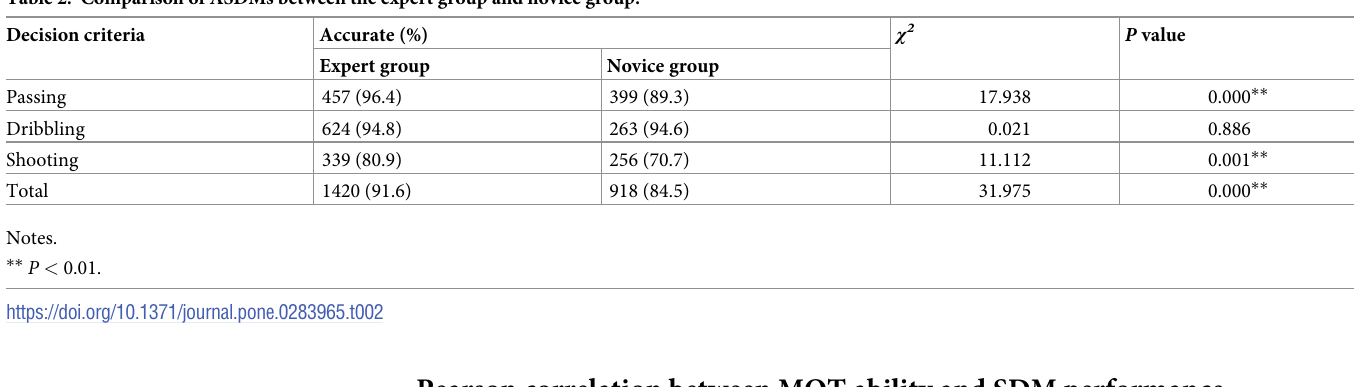
Table 2. Comparison of ASDMs between the expert group and novice group.